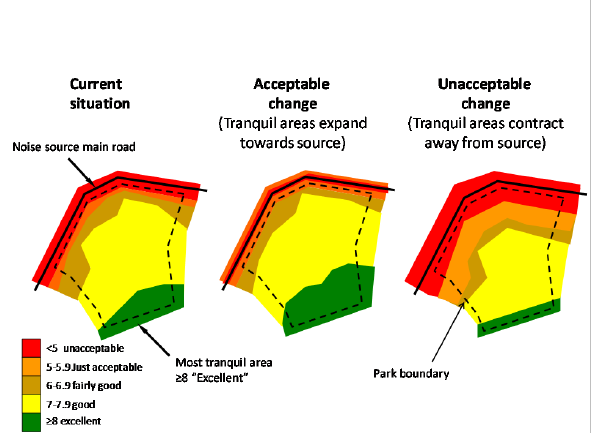
Figure 3: Tranquillity contours showing effects of traflc noise varia-